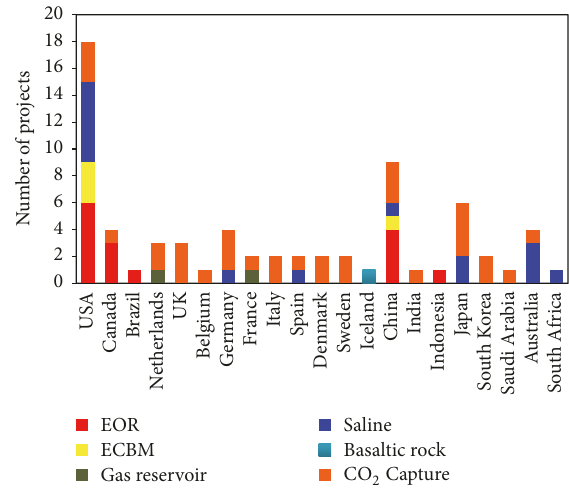
Figure 3: Global distribution of pilot-scale CCUS engineering projects based on project purpose and reservoir types, data sourced from